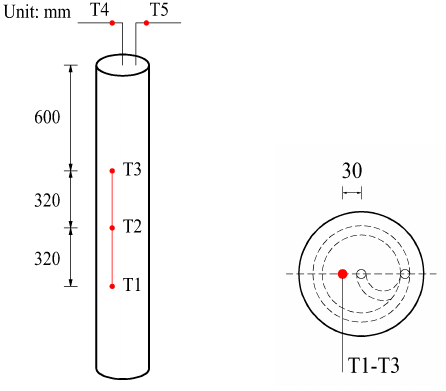
Figure 5. Locations of thermocouples (T1-T5).